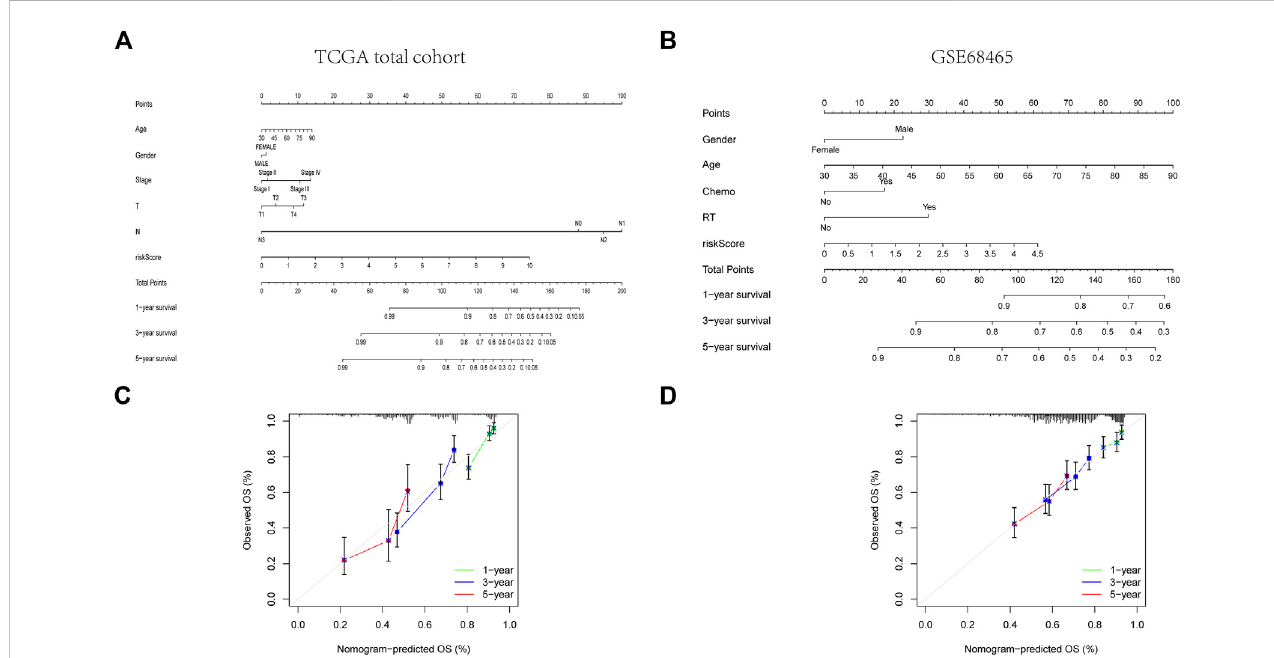
FIGURE 6 Construction of a predictive nomogram. (A, B) The nomogram for OS prediction in LUAD patients at 1, 3, and 5 years. (C, D) Calibration curves of the nomogram for OS prediction at 1, 3, and 5 years.